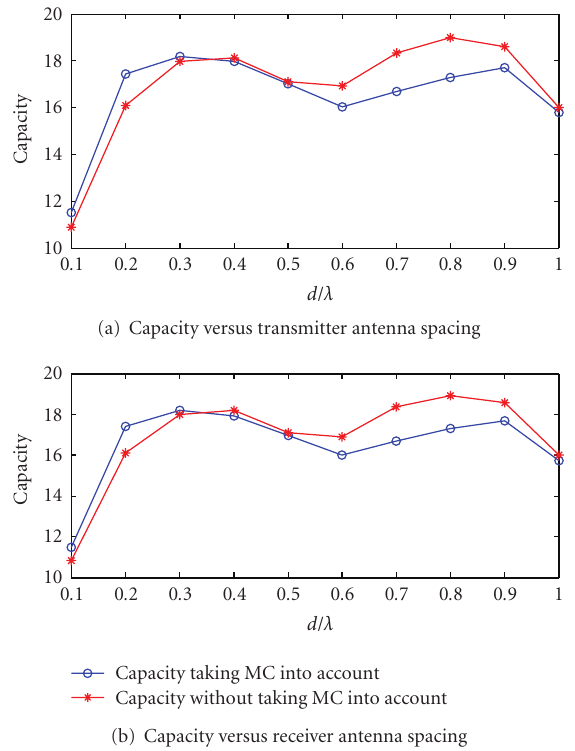
Figure 1: A 4 × 4 MIMO channel capacity considering mutual coupling e ff ect versus transmitter or receiver antenna spacing at SNR equal to 20 dB. (a) Capacity versus transmitter antenna spacing, receiver antenna spacing is set to 1 λ . (b) Capacity versus receiver antenna spacing, transmitter antenna spacing is set to 1 λ